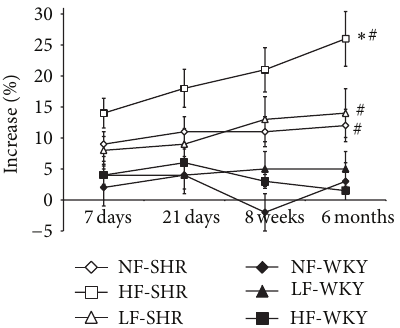
Figure 8: Percentage of increase of acetylcholine-mediated relax- ation by superoxide dismutase (SOD) and catalase determined in mesenteric resistance arteries isolated from WKY rats and SHRs submitted to low flow (LF), high flow (HF), or normal flow (NF) for 1, 3, 8, or 24 weeks. Values represent mean ± SEM ( 𝑛 = 12 rats per group). ∗ 𝑃 < 0.01 , HF or LF versus NF arteries. # 𝑃 < 0.05 , SHRs versus WKY rats, within equivalent arteries (NF, LF, or